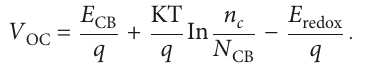
( 10 − 30 C · m) of MS3, TY3, and TY6 in normal